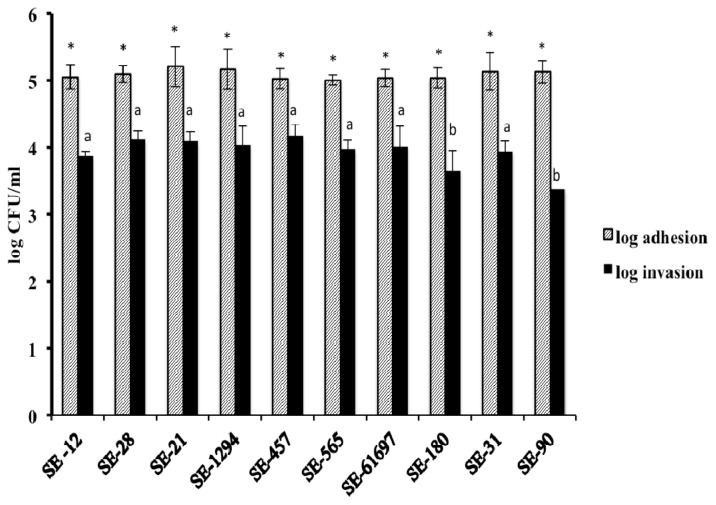
Adhesion to and invasion of 10 strains of Salmonella Enteritidis (SE) on chicken oviduct epithelial cells (COEC). Ten strains of SE were screened to determine their adhesive and invasive properties on COEC. The COEC were seeded on a 24-well tissue culture plates at ~105 cells per well, and inoculated with ~6.0 log CFU of each SE (MOI 10). The infected monolayer was incubated for 1 h following which the cells were lysed and the number of viable adherent SE was determined. For the invasion assay, the monolayers incubated for 1 h following SE infection, were rinsed and incubated for another 2 h in whole media-10% FBS containing gentamicin (100 μg/mL) following which the cells were lysed and SE was enumerated. * Striped bars with asterisks representing adhesion of isolates on COEC did not differ significantly from each other (p > 0.05). a,b Black bars with different superscripts differed significantly in invasion of isolates to COEC (p < 0.05).